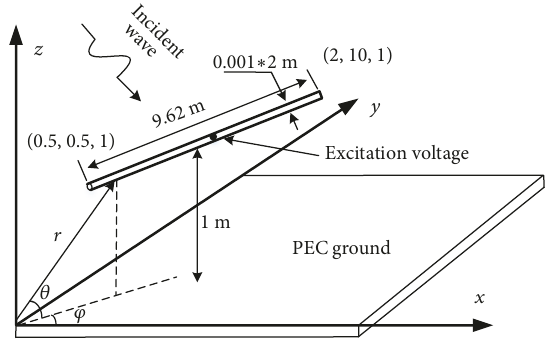
Figure 3: Straight conductor above flat ground. Conductor’s length is 9.62 m, and the height from the ground is 1 m.